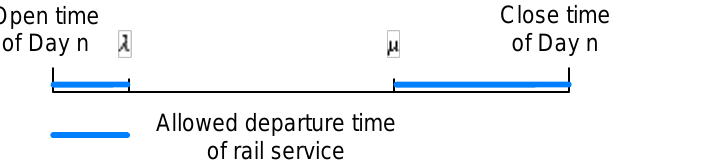
Figure 8. Allowed departure times of rail service Constraint (22) is for departing early in the morning. Constrain (23) is for late departure in the evening. In constraint (24), the sum of and should equal because the departure of rail service is determined by